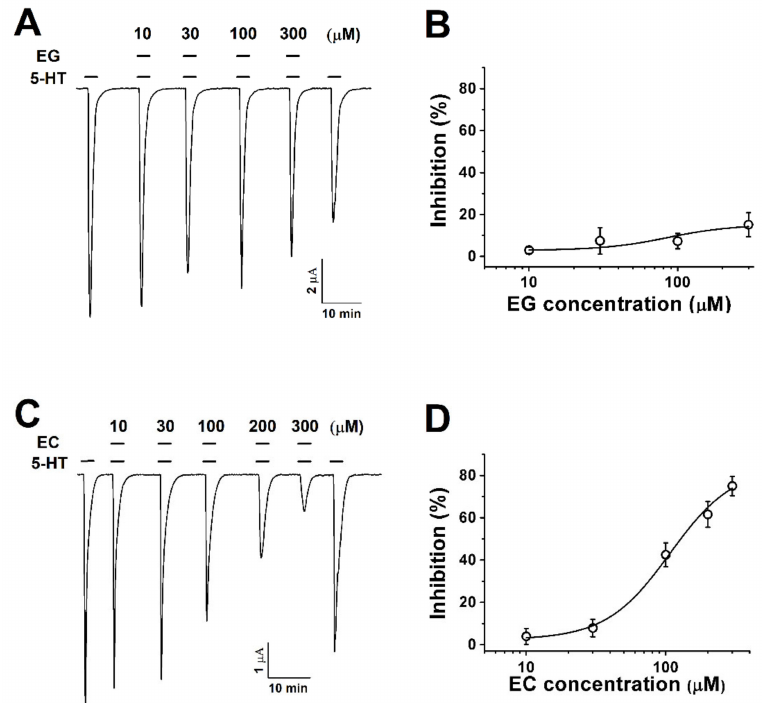
Figure 2. The concentration-dependent response of Xenopus oocytes expressing human 5-HT 3A receptors to ergot alkaloids. ( A ). The traces represent increases in the current inhibition with increases in the ergonovine concentration. Treatment with 5-HT (100 µ M) alone induced an inward current followed by various response traces with 5-HT (100 µ M) and ergonovine (10, 30, 100, and 300 µ M). ( B ). The plot shows the ergonovine inhibition current fitted according to Hill’s equation, where the maximum inhibition (I max ) was 15 ± 5.7%. ( C ). The traces induced by chanoclavine with 5-HT (100 µ M) appear dependent upon the concentration (10, 30, 100, and 300 µ M). ( D ). Average percentage curves of chanoclavine fitted according to Hill’s equation based on the peak of the inward current. The I max was 83.6 ± 12.6%, and the inhibition was 4 ± 3.8%, 7.9 ± 4.1%, 42.5 ± 5.7%, 61.6 ± 6.1%, and 75 ± 4.5% at 10, 30, 100, 200, and 300 µ M, respectively. The oocytes expressing human 5-HT 3A mRNA were held at − 80 mV, and each value represents the mean ± SEM ( n = 8–10 from four different